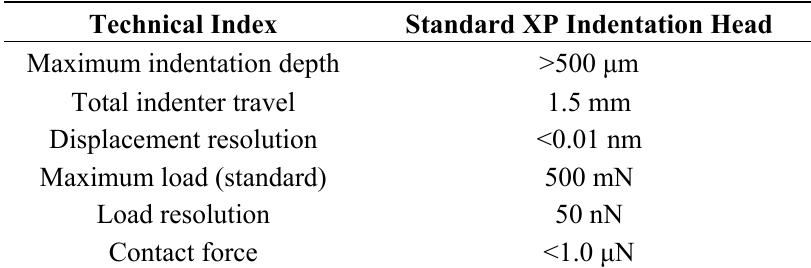
Table 1. Main parameters of nano indenter